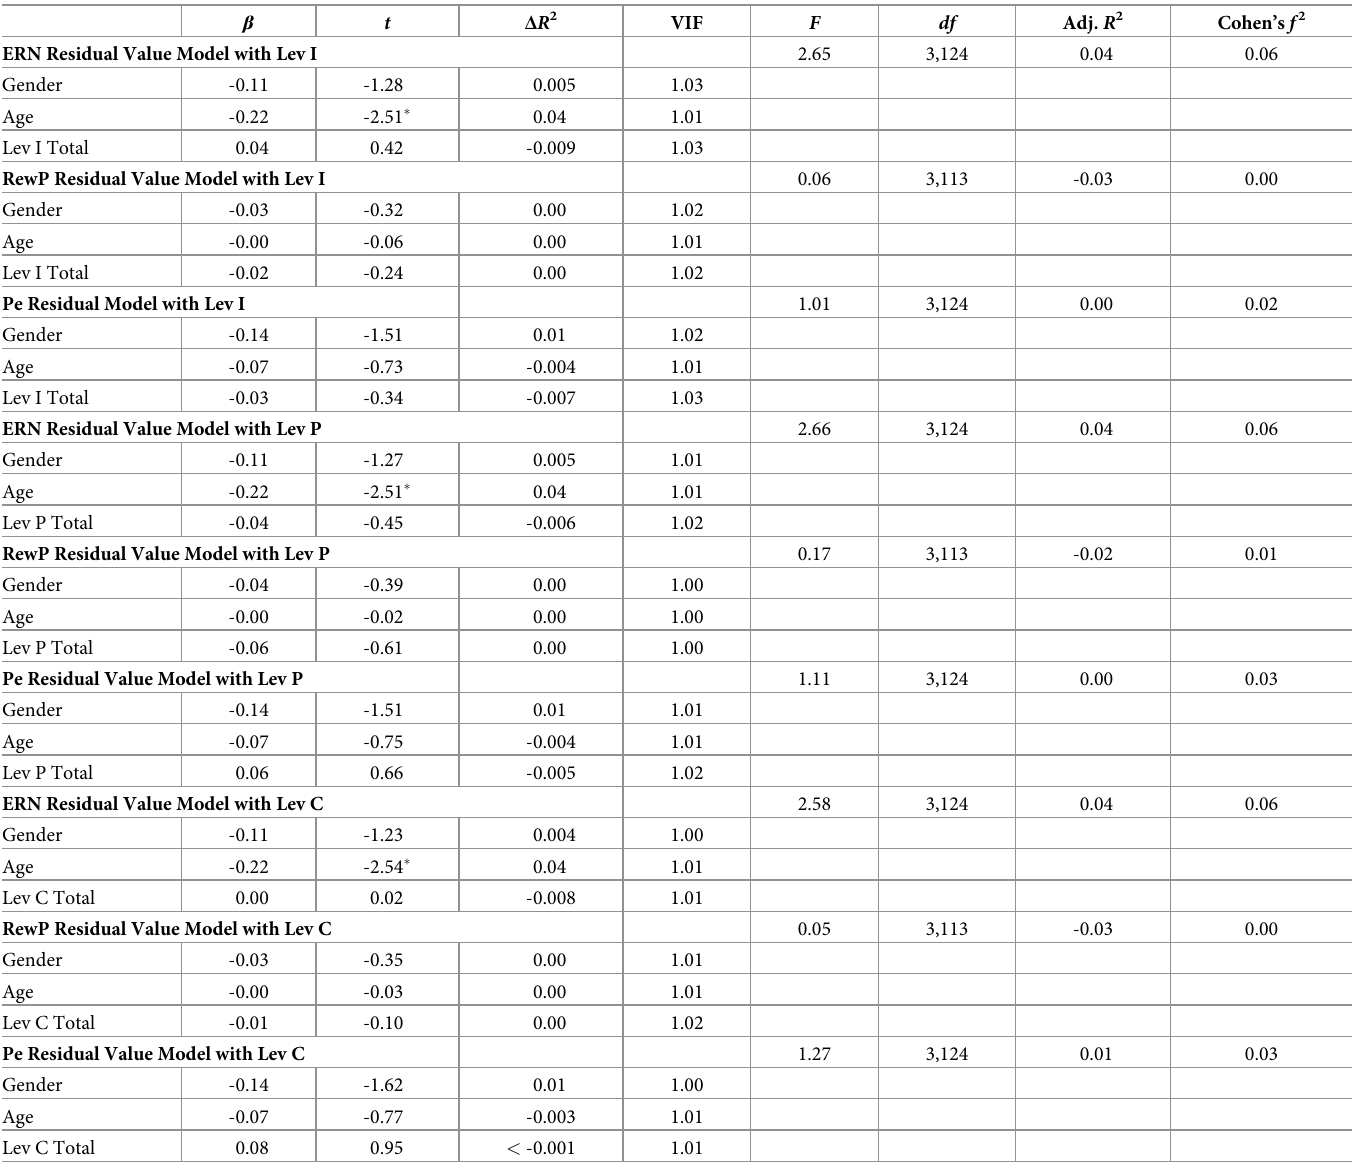
Table 6. Multiple linear regressions with Levenson subscales locus of control predicting residual